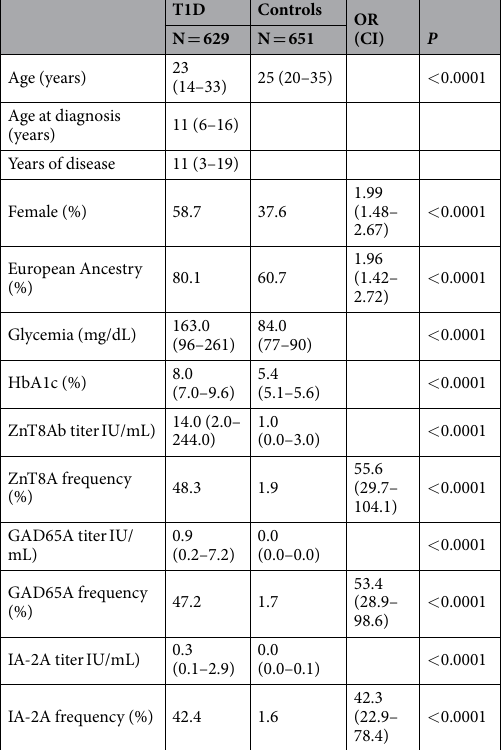
Table 1. Demographic and laboratory characteristics of patients with T1D and controls. Data are presented as median and (inter-quartile range). HbA1c = glycated hemoglobin; ZnT8A = Zinc transporter-8 autoantibody; GAD65A = glutamic acid decarboxylase 65 autoantibody, IA-2A = tyrosine phosphatase